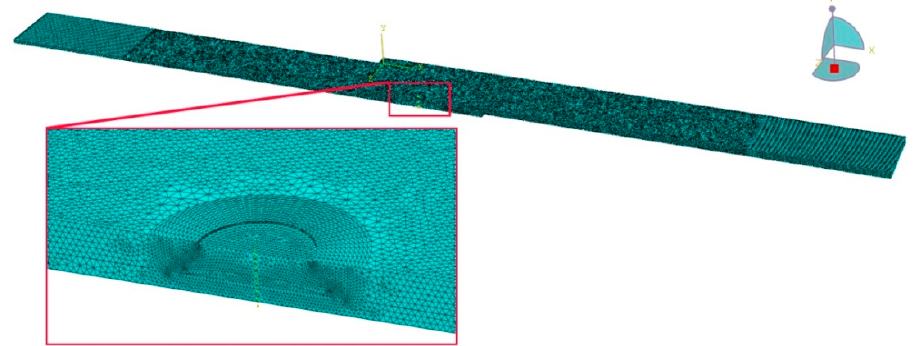
Figure 6. Finite element mesh of a single-lap RFSSW joint.